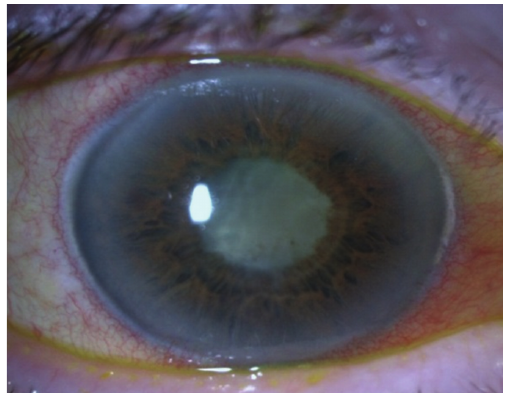
Figure 5: Biomicroscopy OD—total cataract and posterior synechia 360 ∘